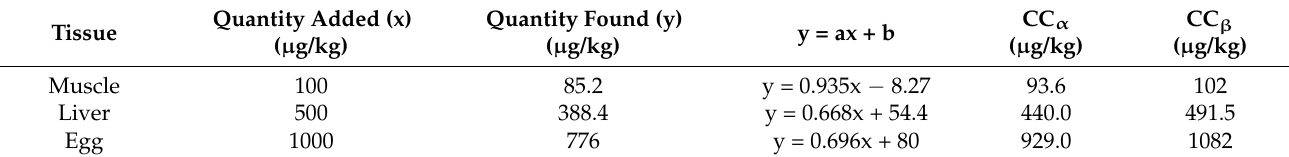
Table 9. Decision limit (CC α ) and detection capability (CC β